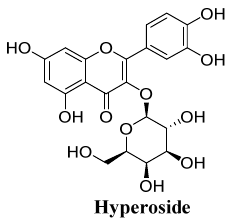
Figure 16. Hyperoside.